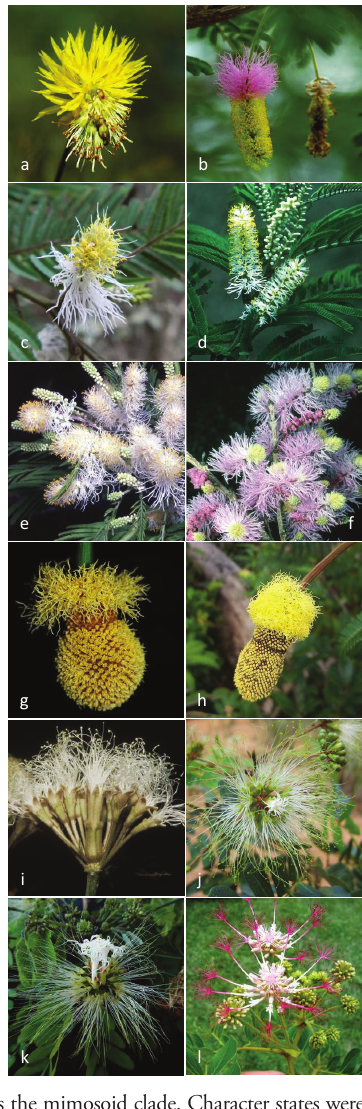
Figure 14. Evolution of types of floral heteromorphy across the mimosoid clade. Character states were de- fined as: homomorphic , i.e. with no conspicuous modification or variation amongst flowers within an inflores- cence (here we include inflorescences that can comprise proportions of male and bisexual flowers, but no other more conspicuous variation); heteromorphic 1 = basal flowers of the inflorescence with showy staminodia; het- eromorphic 2 = flowers dimorphic within an inflorescence, the central flower (or flowers) enlarged/sessile cf. the peripheral (sometimes pedicellate) flowers. Branch lengths are not informative in this figure. Photos a–h heter- omorphic 1 a Neptunia plena (L.) Benth. b Dichrostachys cinerea (L.) Wight & Arn. c Dichrostachys